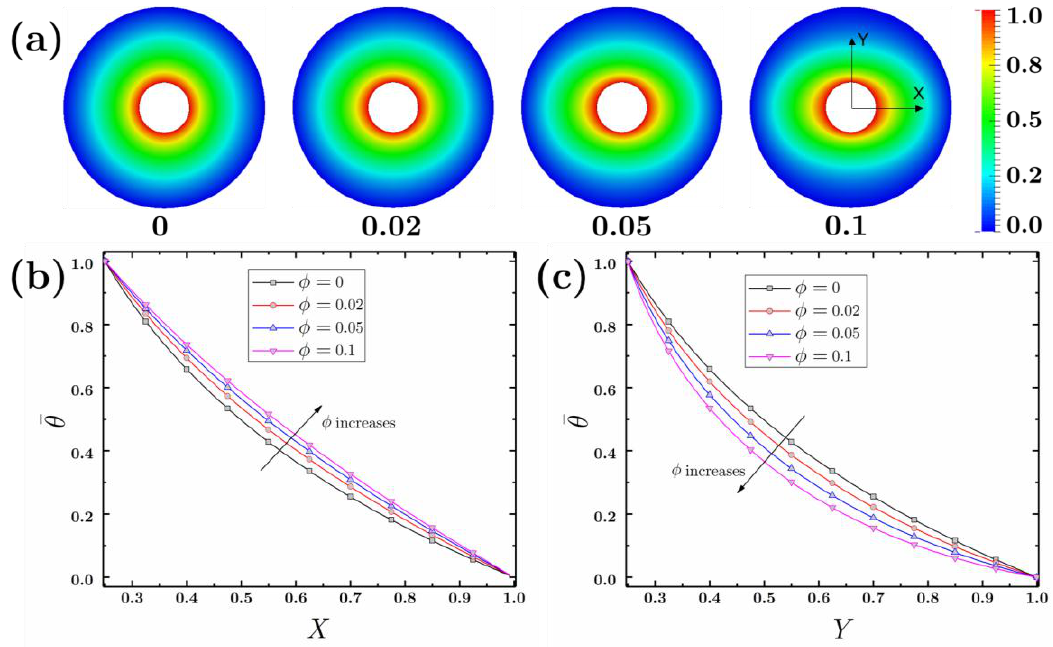
Figure 5. Effect of nanoparticles concentration ( φ ) on ( a ) steady-state temperature distribution; ( b ) steady-state temperature profiles along the X -direction; and ( c ) steady-state temperature profiles along the Y -direction. For this figure, Ha = 1.0 and β = 0 ◦ .